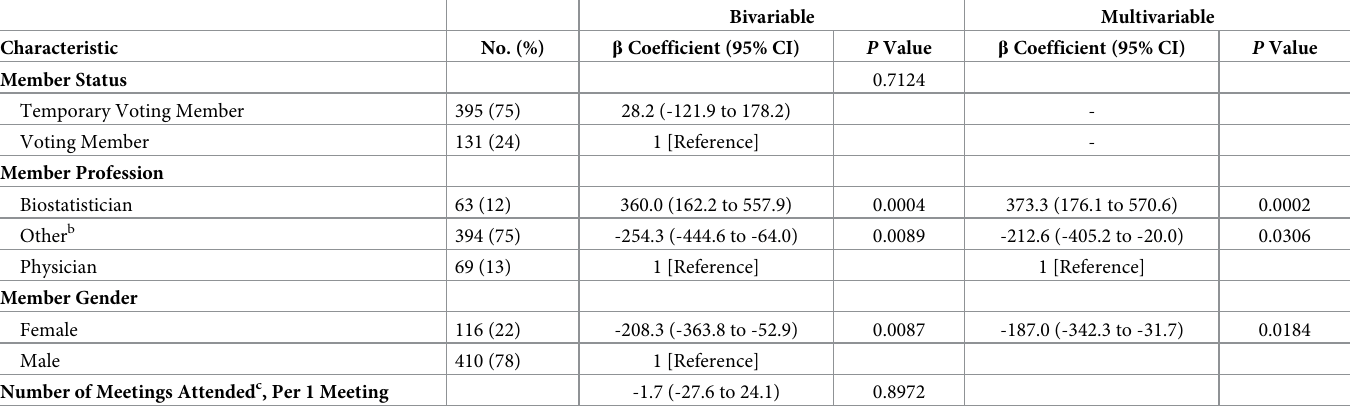
Table 2. Relationship between voter characteristics and talkativeness a in the univariable and multivariable linear regression analyses. Bivariable